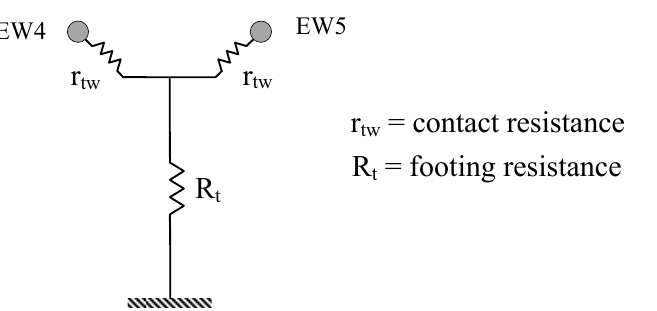
Figure A3. Two earth wires earthing at tower.